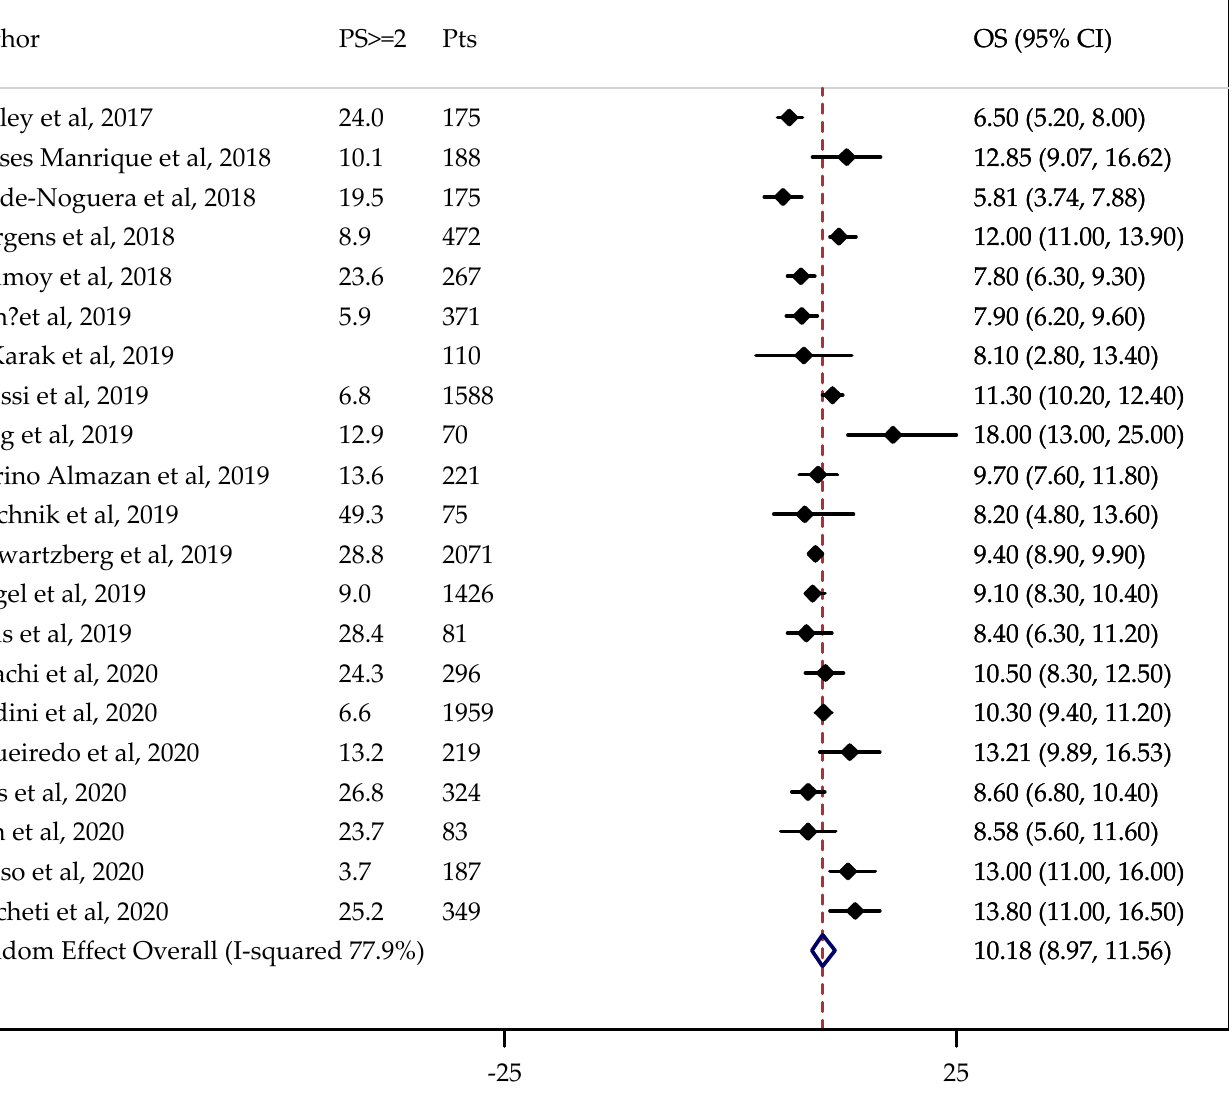
Figure 5. Forest plot of NSCLC overall survival (OS) adjusted for performance status (PS). PS ≥ 2: proportion of patients with PS ≥ 2.